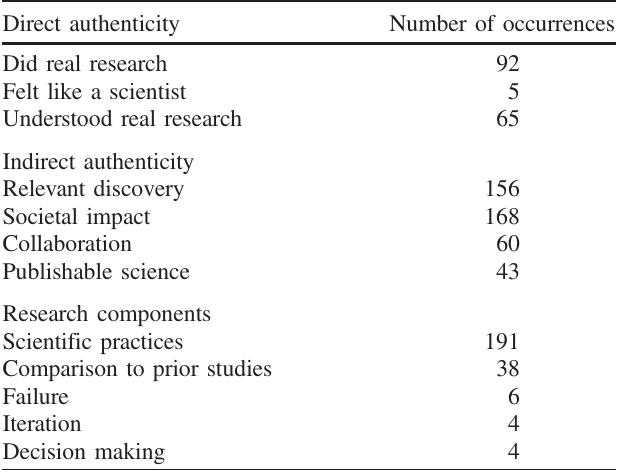
TABLE II. Number of memos assigned to each code. The total number of students who wrote a memo was 405, and 314 students indicated that their research was authentic in some